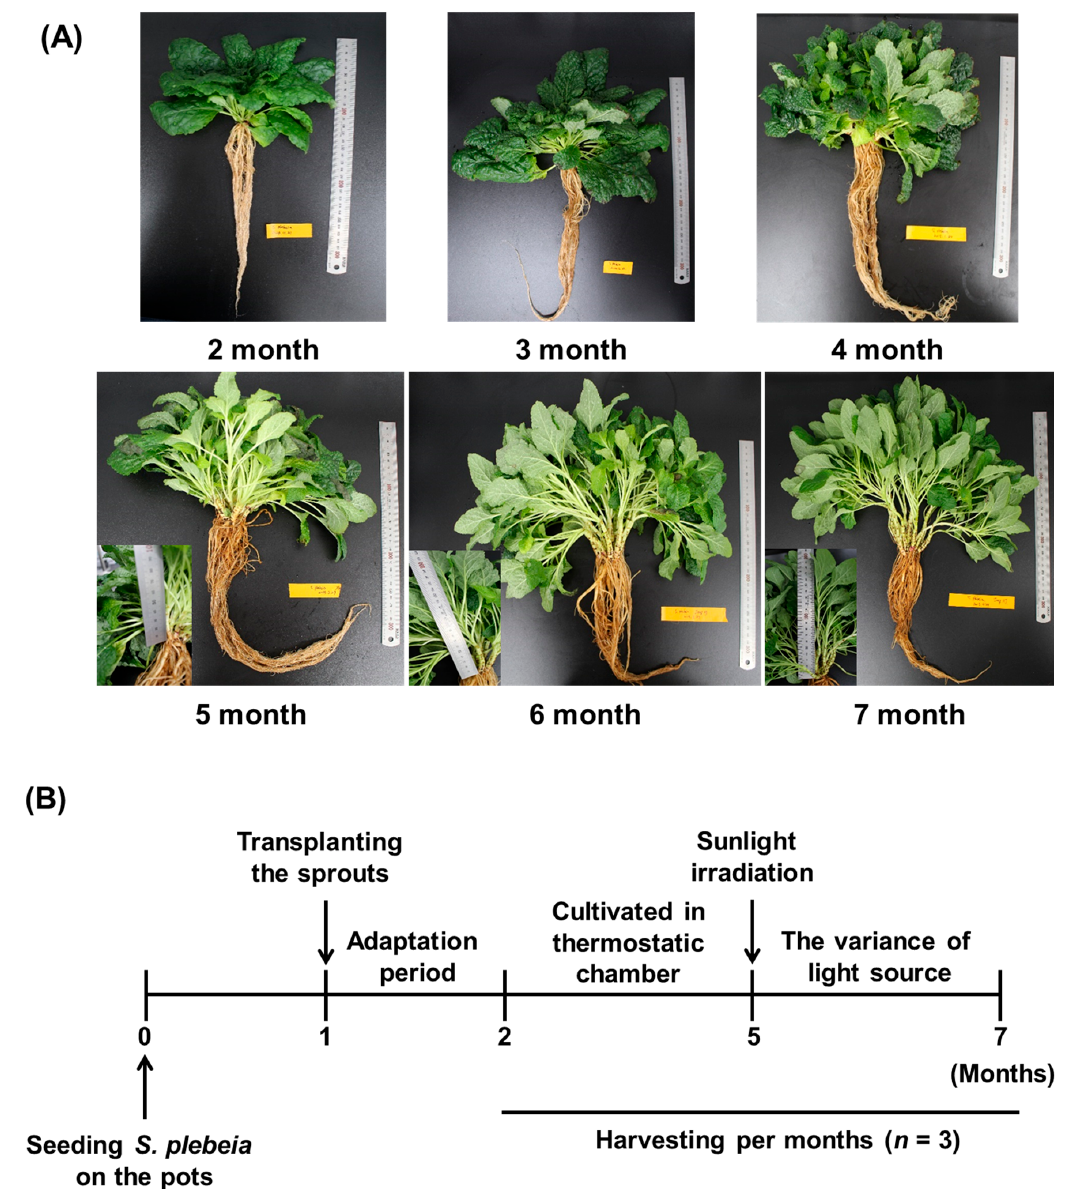
Figure 1. Appearance of Salvia plebeia cultivated under different light sources, including fluorescent light and natural sunlight ( A ) and the experimental design ( B ).